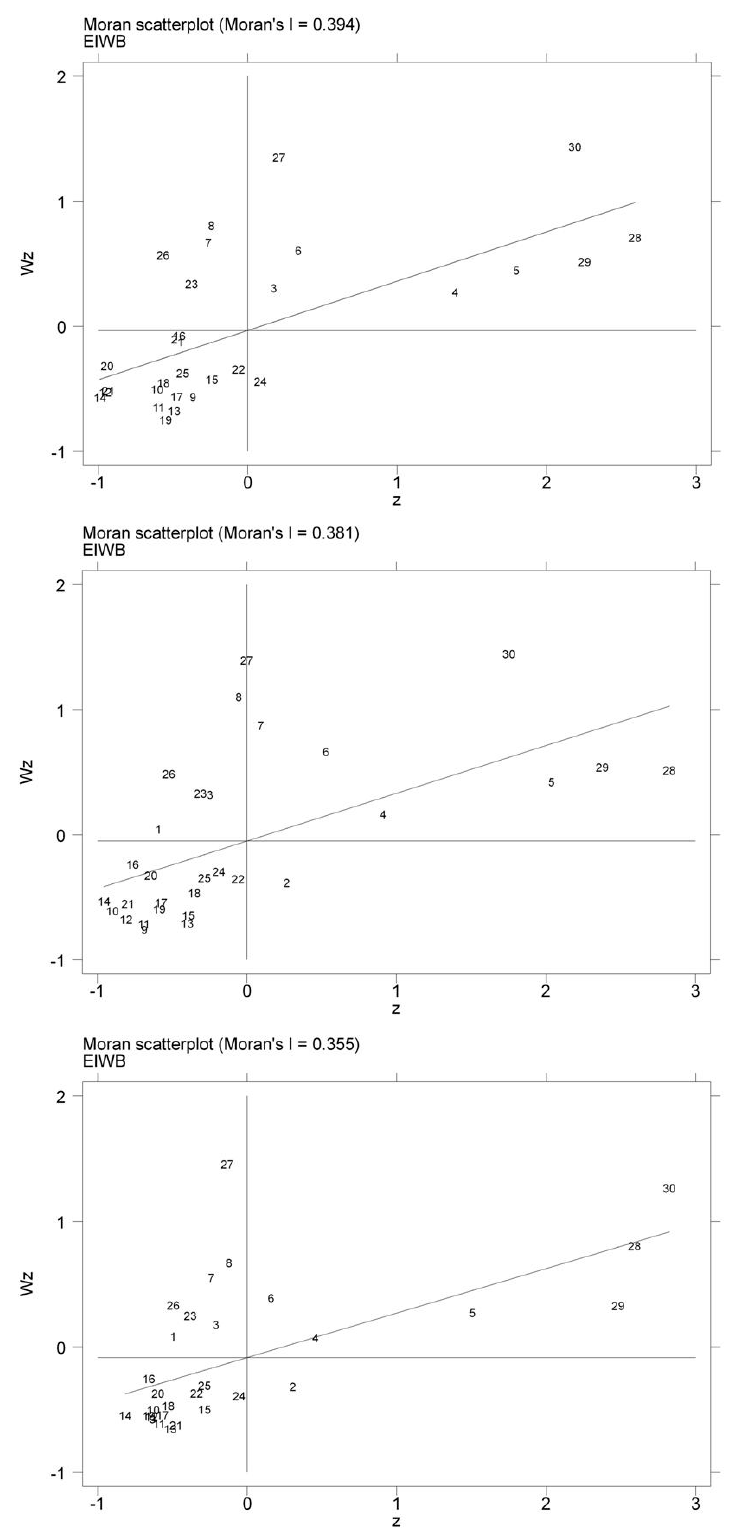
Figure 7. Local Moran scatter plots of China’s EIWB (in 2006, 2011 and 2016). Note: The numbers in the figure represent provinces, and their position in each quadrant was compiled based on the results of Local Moran’s calculation results of Local Moran’s I.